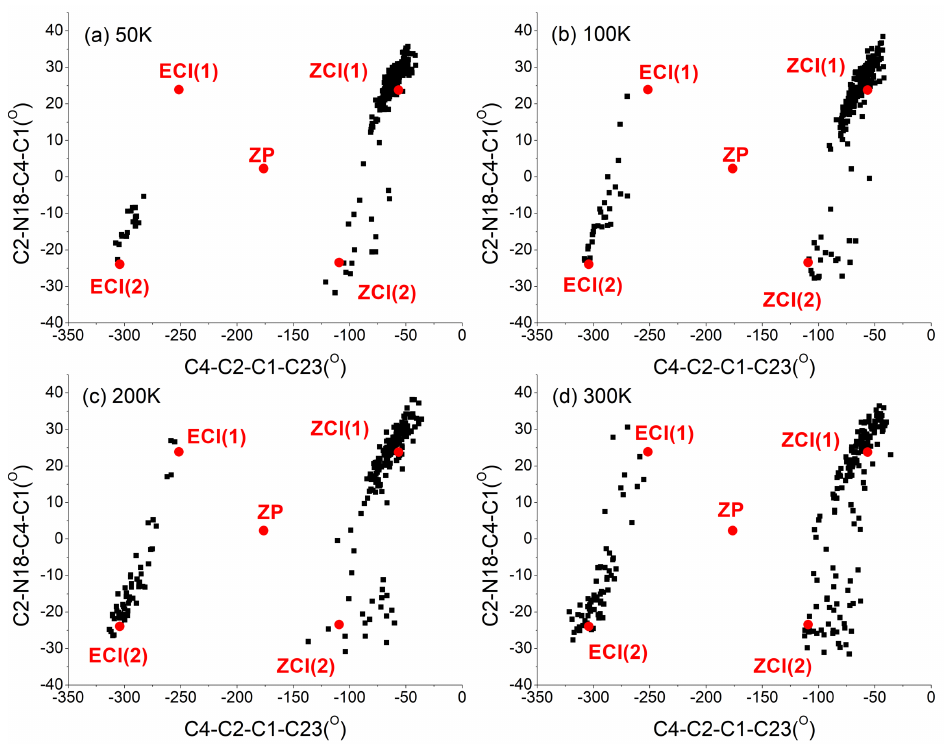
Figure 8. Distribution of the C4-C2-C1-C23 and C2-N18-C4-C1 dihedral angles at the hopping events of successful ZP → EP photoisomerization trajectories starting from the ZP structure of DDPY at ( a ) 50 K; ( b ) 100 K; ( c ) 200 K; and ( d ) 300 K, respectively. The ground state ZP isomer, E CI(1), E CI(2), Z CI(1), and Z CI(2) are also presented in this figure at different